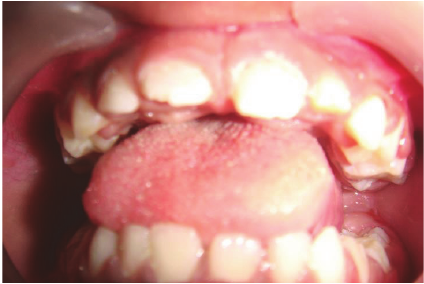
Figure 3: Postoperative photograph (Case 1